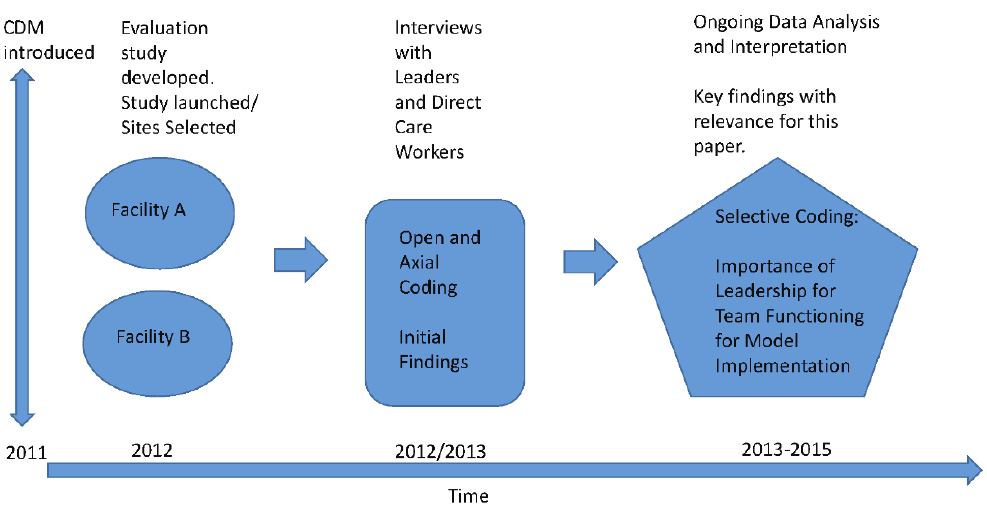
Figure 1. CMD implementation evaluation study.